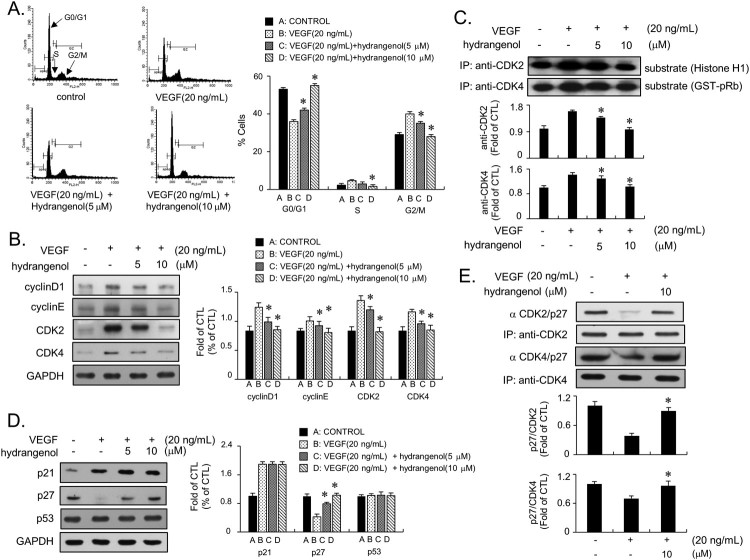
Hydrangenol induces G1-cell cycle phase arrest via p27KIP1 expression in VEGF-treated HUVECs. (A) Histograms from flow cytometry analysis of VEGF-stimulated HUVECs in the presence and absence of hydrangenol. The graph shows the distribution of cell populations in each cell cycle phase. (B) Immunoblots of cell cycle regulators in the G1-cell cycle phase. Hydrangenol-mediated changes in the levels of cyclin D1, cyclin E, CDK2, and CDK4 in VEGF-stimulated HUVECs were measured and presented in the bar graph. (C) Kinase assay was performed to evaluate the effect of hydrangenol on CDK2 and CDK4 activities. Cell lysates were collected and immunoprecipitated using anti-CDK2 and anti-CDK4 antibodies. Kinase activities of CDK2 and CDK4 were measured using histone H1 and GST-Rb as substrates, respectively. (D) Immunoblots for cell cycle inhibitors. Levels of p21WAF1, p27KIP1, and p53 were measured in VEGF-stimulated HUVECs treated with and without hydrangenol. The bar graphs were presented as a fold change compared with the control. (E) Cell lysates were immunoprecipitated using anti-CDK2 and anti-CDK4 antibodies, and then the immunoprecipitates were performed by the immunoblot assay using an anti-p27KIP1 antibody. All data are reported as means ± SE from three independently repeated experiments. *p < 0.05 compared with VEGF treatment.